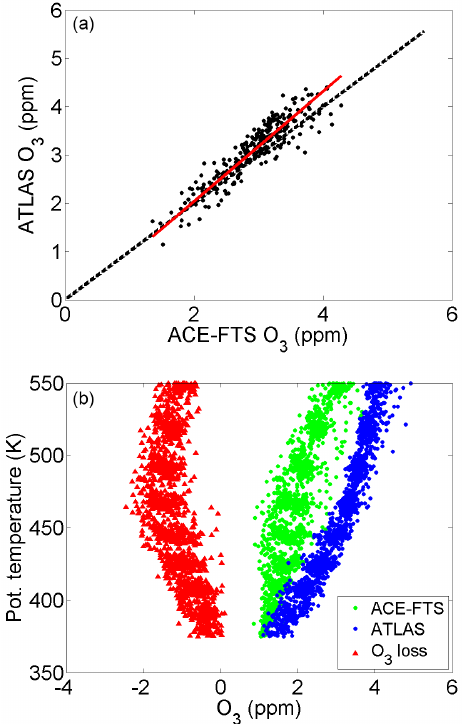
Figure 4. (a) shows a comparison between the ATLAS passive ozone and ACE-FTS ozone dataset inside the polar vortex for Jan- uary 2011. The black dots represent the individual data points and the red line indicates the line of best fit. For easy comparison, the one-to-one line is shown as a black dashed line. (b) shows ATLAS passive O 3 (blue dots), ACE-FTS measurements (green dots), and the ozone loss (red triangles; the difference between observed and average passive ozone) for March